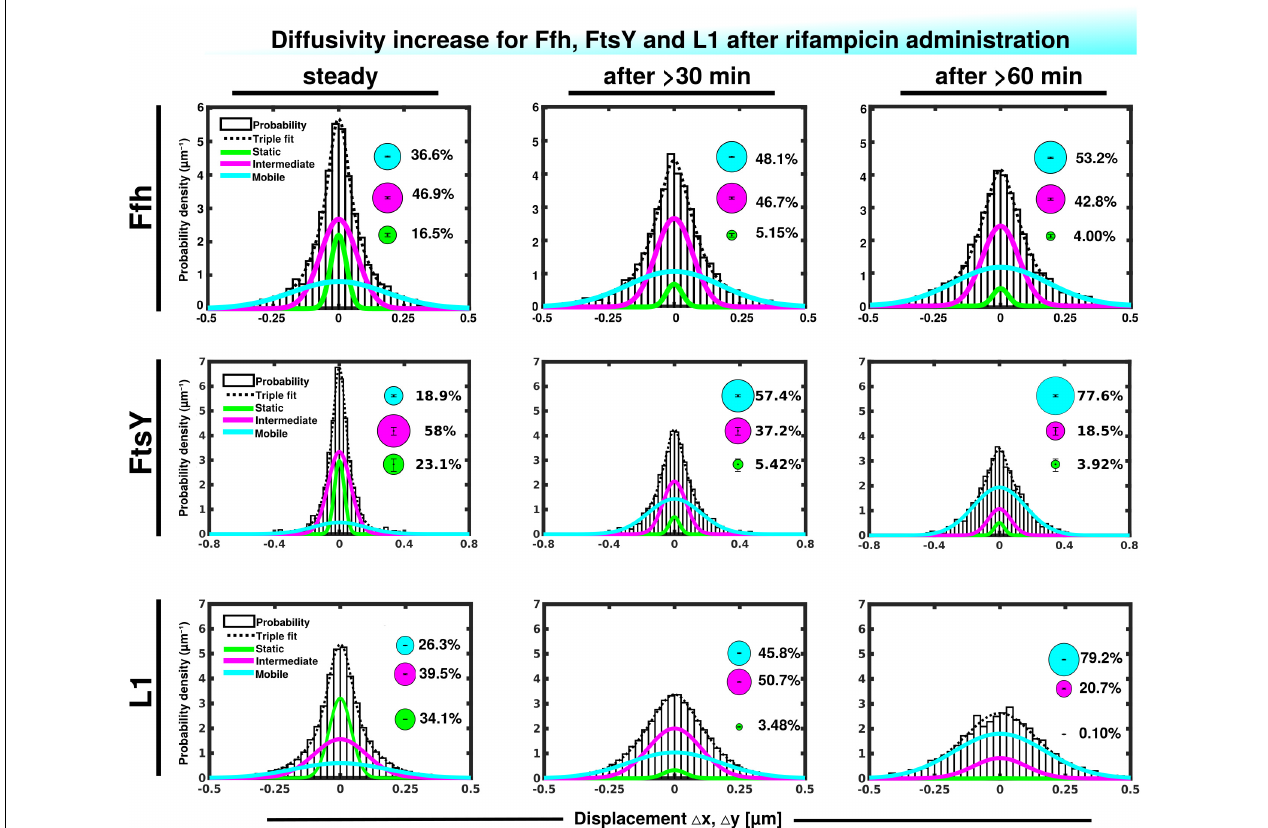
FIGURE 4 | Gaussian mixture model (GMM) analyses of protein dynamics in response to rifampicin treatment, inhibiting transcription (tracking 30 or 60 min after addition of a sublethal concentration of Rif). Population sizes of mVenus fusions and time of imaging after addition of rifampicin are stated in the panels. Bubbles illustrate fraction sizes, fractions are indicated by the different colored lines, analogous to Figure 3C